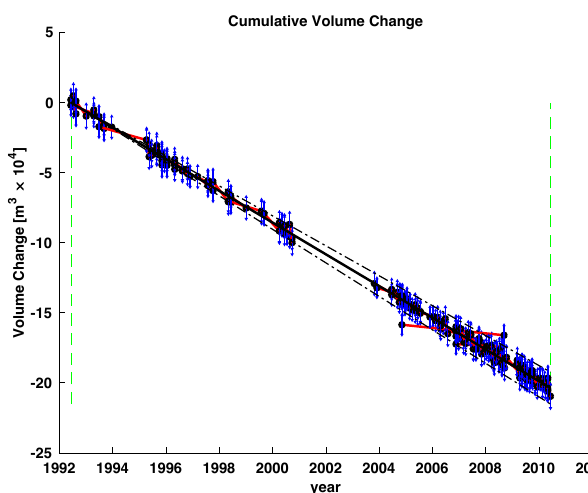
Figure 6. Time series at San Emidio, showing cumulative volume change from temporal adjustment of volume change rates estimated from InSAR data spanning 1992 to 2010. Black lines show the modeled volume change with 68% confidence intervals (dashed lines) as estimated by temporal adjustment with a single-rate temporal function [31]. Red segments indicate measurements of observed volume change derived from individual interferometric pairs. For each pair, the volume change at the mid-point of each time interval is plotted to fall on the modeled curve and the vertical blue bars denote 1 σ measurement uncertainty, after scaling by the square root of the variance scale factor (i.e., the dimensionless misfit χ